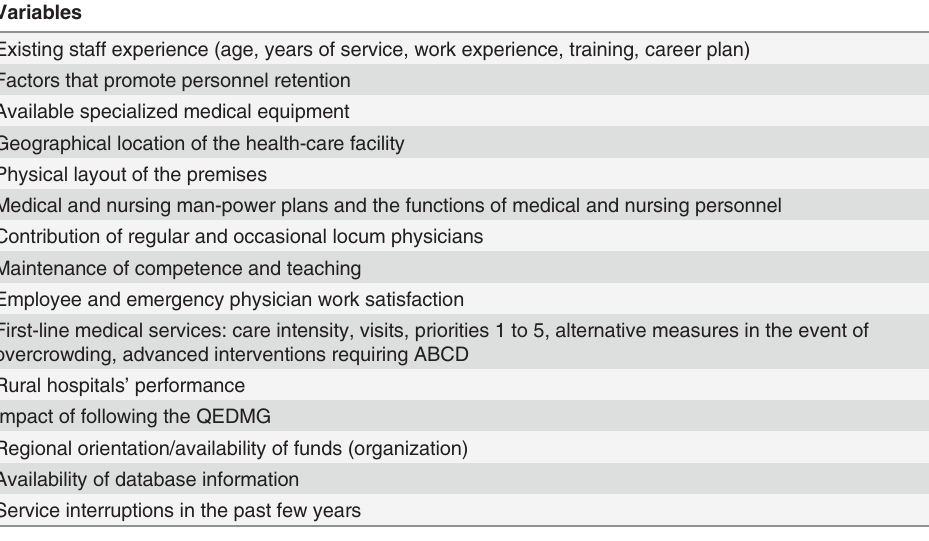
Table 2. New variables for inclusion proposed by participants.